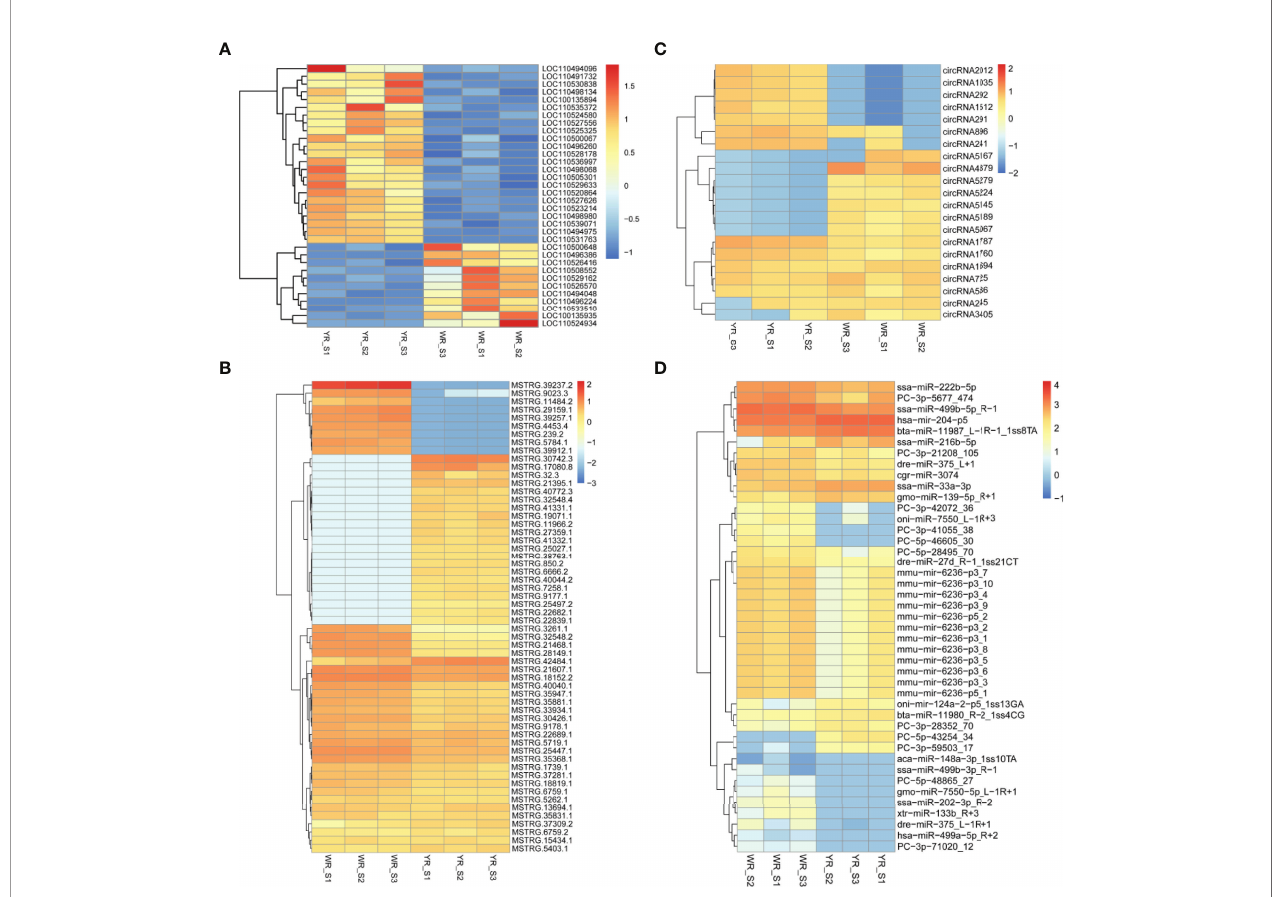
FIGURE 3 | Unsupervised clustering analysis of DEmRNAs and DEncRNAs between WR_S and YR_S groups. (A) DEmRNAs. (B) DElncRNAs. (C) DEcircRNAs. (D)